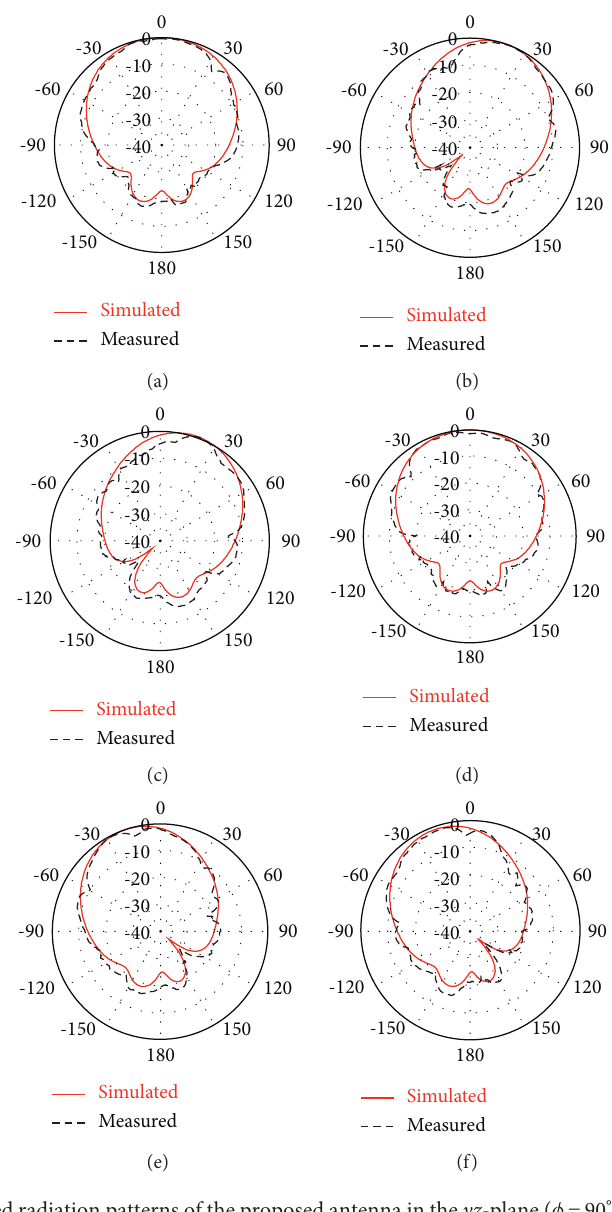
Figure 12: Simulated and measured radiation patterns of the proposed antenna in the yz -plane ( ϕ � 90 ° ) at 5.82GHz: (a) State 1, (b) State 2, (c) State 3, (d) State 4, (e) State 5, and (f) State (right endfire), − 15 ° (left endfire), − 20 ° (left endfire), − 15 ° (left endfire), and 16 ° (right endfire), for State 1 to State 6, respectively.